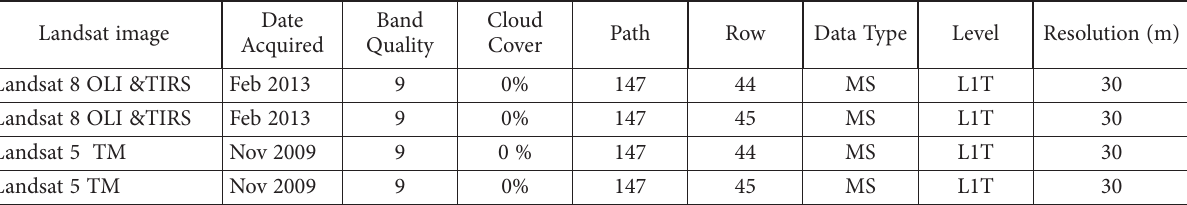
Table 1. General characteristics of Landsat scenes used for study area Landsat